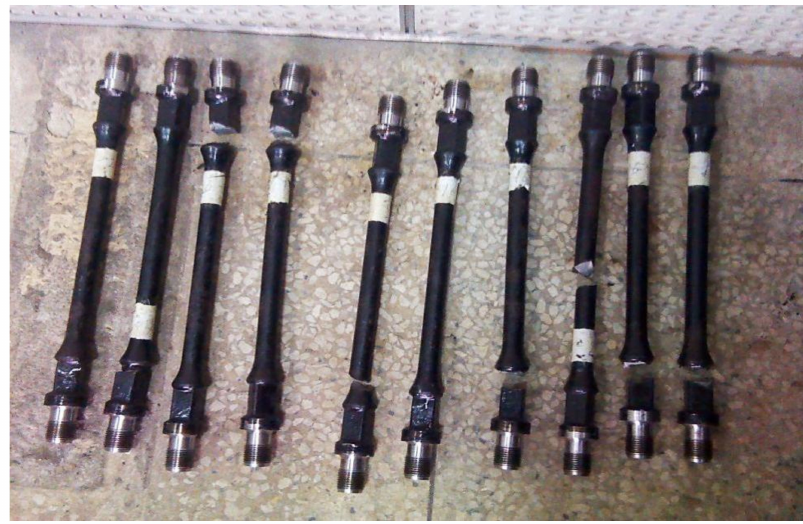
Figure 3. Some specimens after fatigue